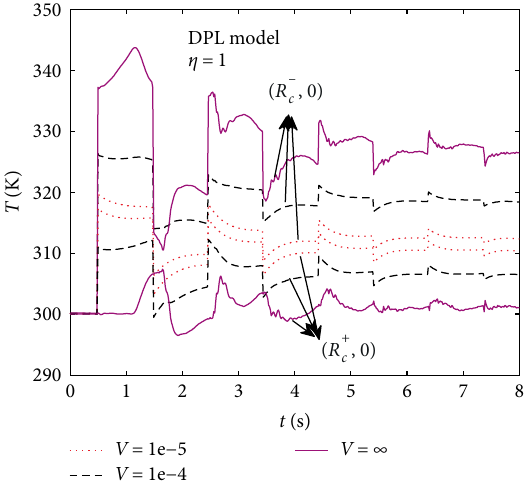
based on the DPL model. 휂 = 1